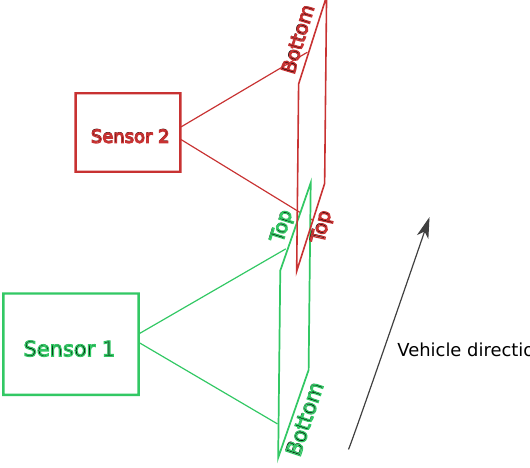
Figure 8. Relative orientation and position of the images taken by both sensors at each acquisition.